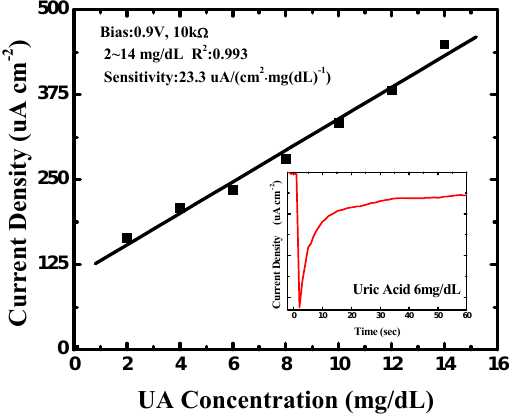
Figure 7. Uric acid concentration response of the uric acid biosensor with amperometric readout